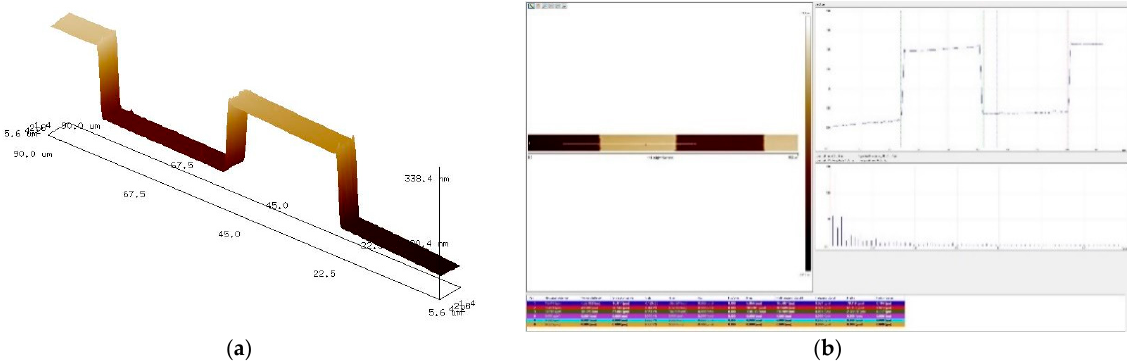
Figure 9. Test results of aberrated off-axis Fresnel zone plate. ( a ) the microstructure ( b ) the atomic force software tests.